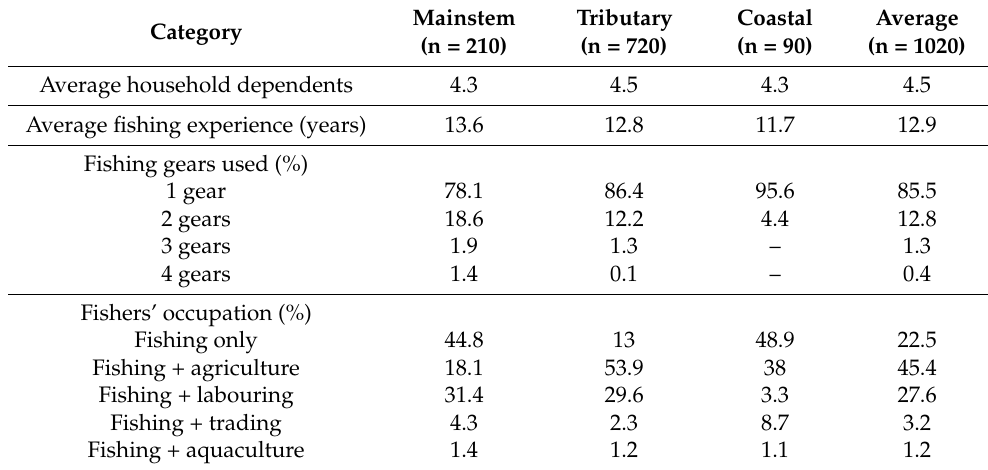
Table 1. General profile of fishers.